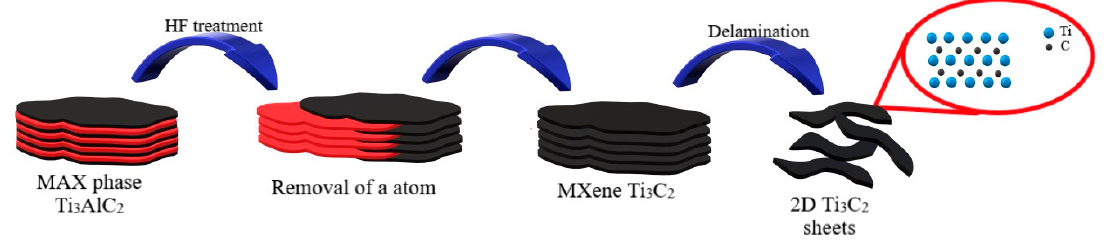
Figure 1. Schematic diagram of the preparation of 2D Ti 3 C 2 T x MXene from starting Ti 3 AlC 2 MAX